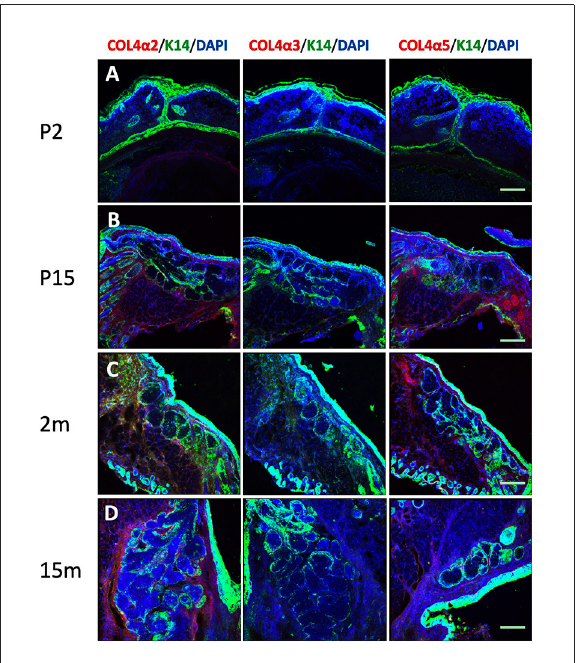
FIGURE2 Identification of cytokeratin 14 (K14, green), collagen IV α 2 (COL4 α 2, red), collagen IV α 3 (COL4 α 3, red) and collagen IV α 5 (COL4 α 5, red) in the mouse Meibomian gland of different developmental stages. Nuclei were counterstained with 4’, 6-Diamidino-2-phenylindole (DAPI) in blue. (A) postnatal day 2 (P2); (B) postnatal day 15 (P15); (C) 2 months old; and (D) 15 months old. Scale bar = 50 µ